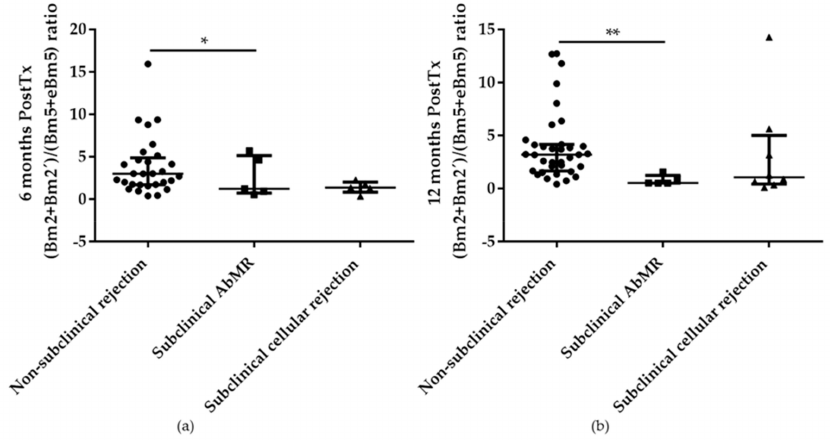
Figure 8. Significant reduction of active / memory B cells ratio between patients with subclinical antibody-mediated rejection (AbMR; n = 5) detected retrospectively in the surveillance biopsy performed at 1 year after kidney transplantation, and non-rejection patients ( n = 38) at 6 months ( a ) and 12 months ( b ) after kidney transplantation. * indicates p < 0.05, and ** p <